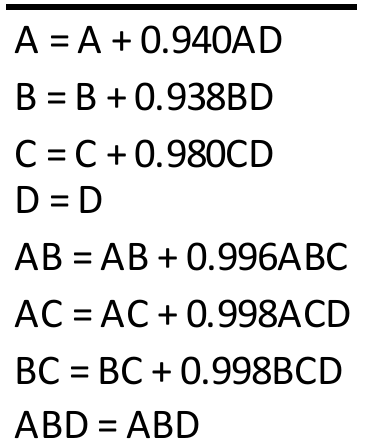
Figure 14. Alias structure for EA (24, 3 2 5 1 7 1 ).